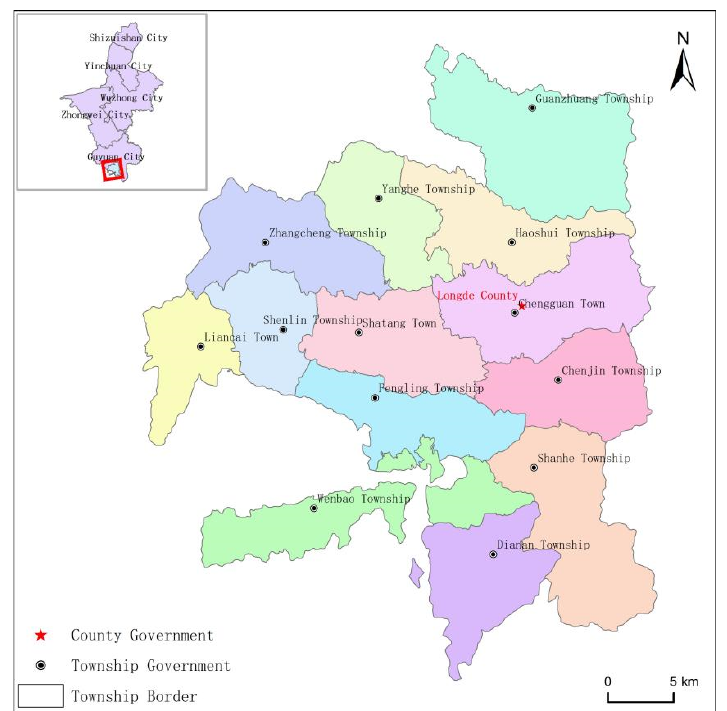
Figure 2. Administrative map of Longde County.